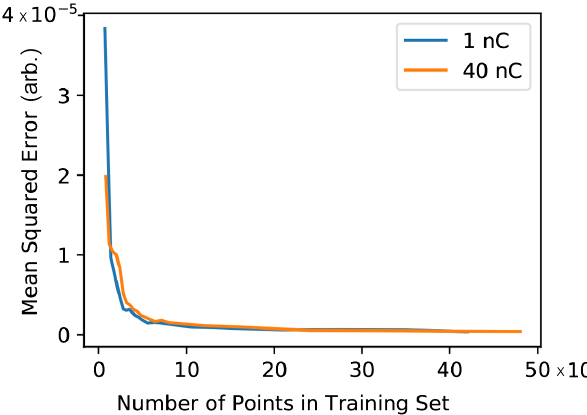
FIG. 7. Prediction error in normalized units for the AWA model trained on various training set sizes. After a few thousand points, we see diminishing returns.